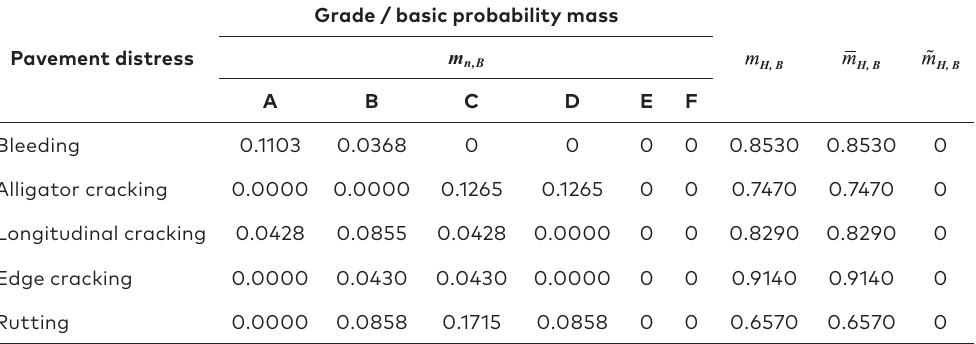
Table 7. Basic probability masses of various assessment grades for all distresses in pavement Section